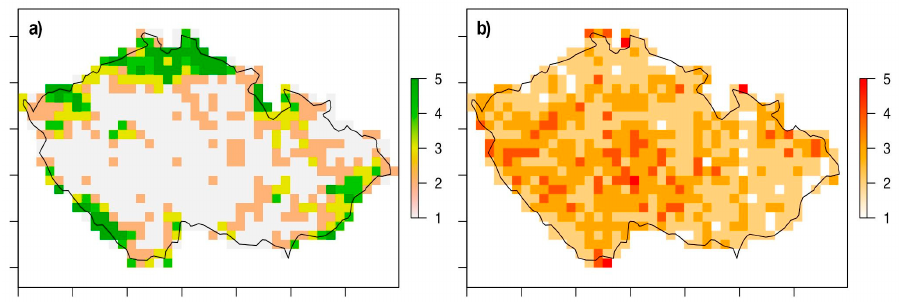
Figure 1. Both the ( a ) naturalness and ( b ) degradation parameters take on values from 1 (the lowest level of parameter) to 5 (the highest level of parameter).